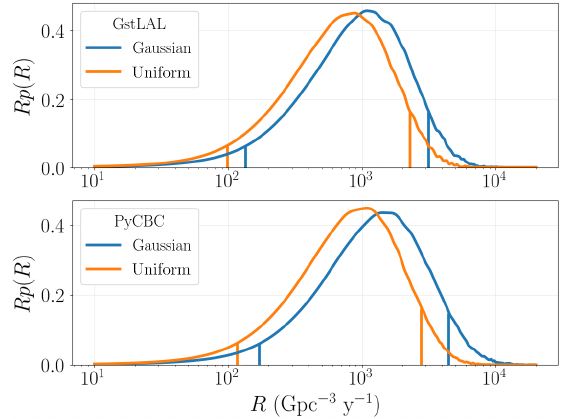
FIG. 14. This figure shows the 90% rate upper limit for the NSBH category, measured at a set of three discrete BH masses (5, 10, and 30 M ⊙ ) with the fiducial NS mass fixed to 1 . 4 M ⊙ . The upper limit is evaluated for both matched-filter search pipelines, with GstLAL corresponding to red curves and PyCBC to blue. We also show two choices of spin distributions: isotropic (dashed lines) and aligned spin (solid